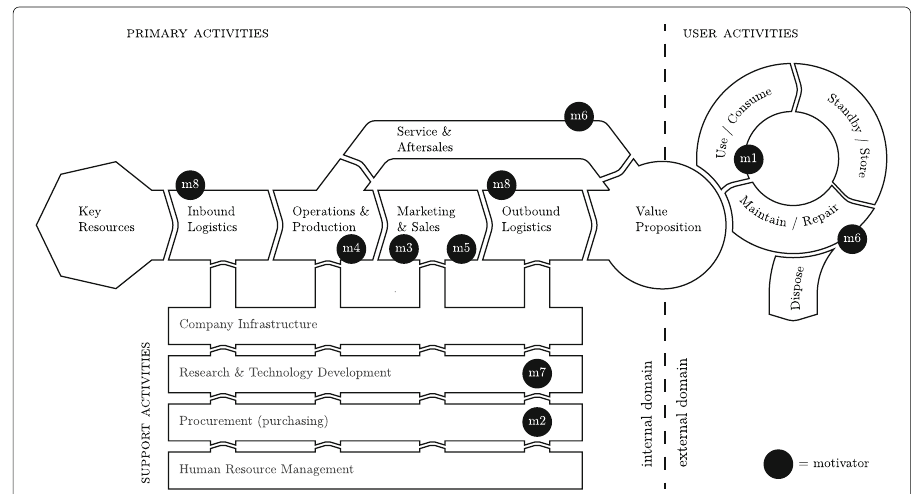
Fig. 1 Extended value-chain model to facilitate allocation of enterprise motivators for development and deployment of IoT applications